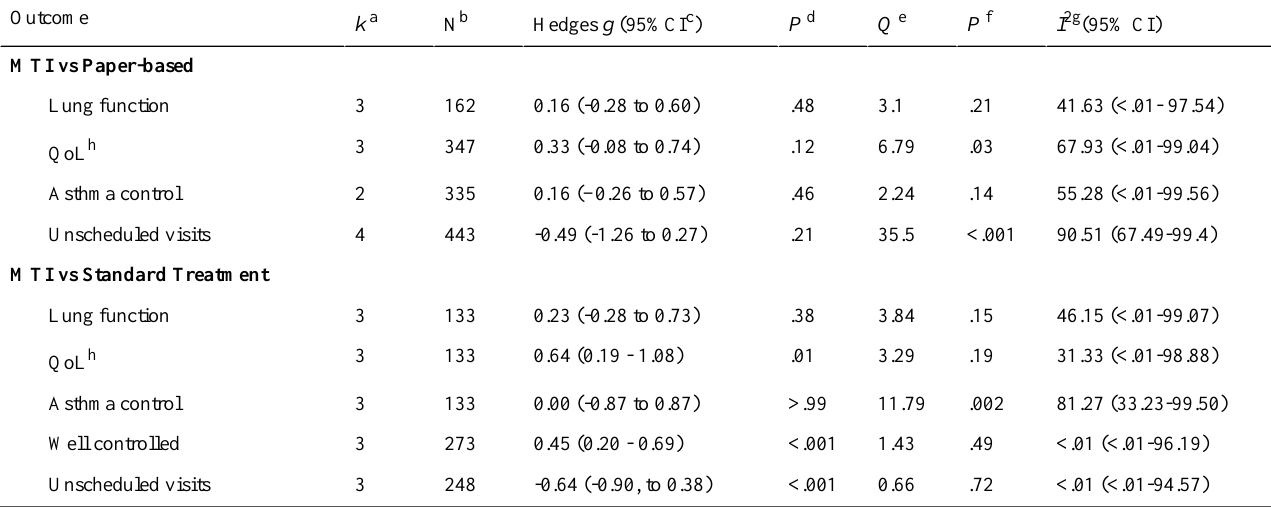
Table 5. Hedges g and tests of heterogeneity of mobile technology intervention (MTI) for clinical outcomes.